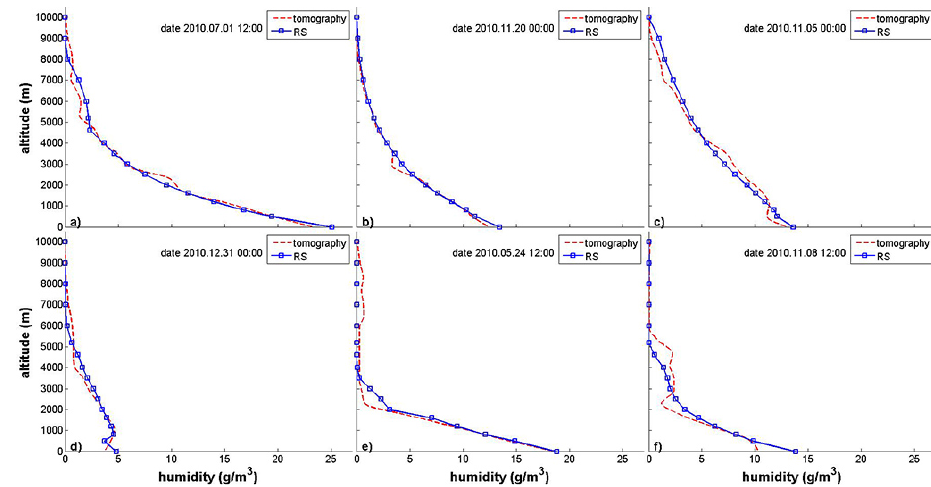
Figure 7. Representative cases of tomographic solution and radiosonde data during our long-term study.